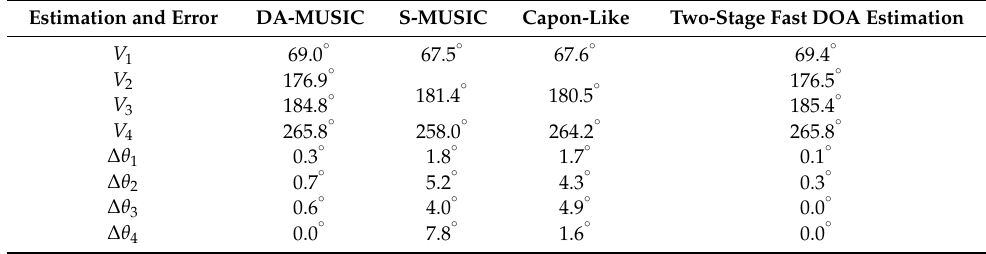
Table 4. Multi-target DOA estimation values and errors for the four different targets. Estimation and